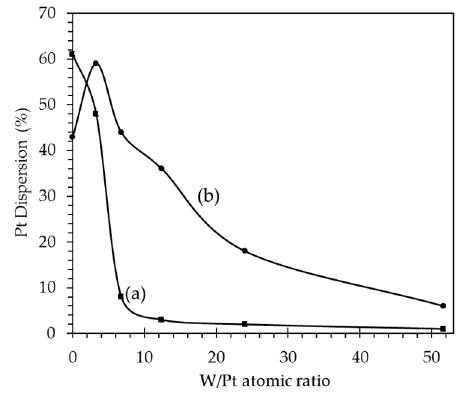
Figure A2. Dispersion of Pt in Pt / AW catalysts increasing the W / Pt atomic ratio when the reduction temperature in H 2 increased from ( a ) 500 to ( b ) 800 °C (for 4 h).